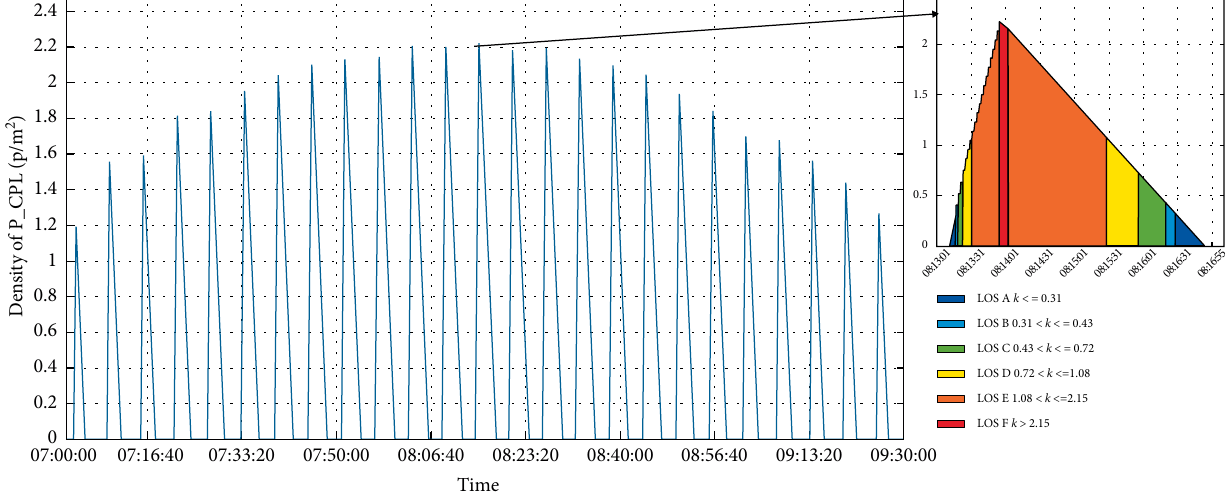
Figure 10: Time-varying LOS on P_CPL for the full simulation period.